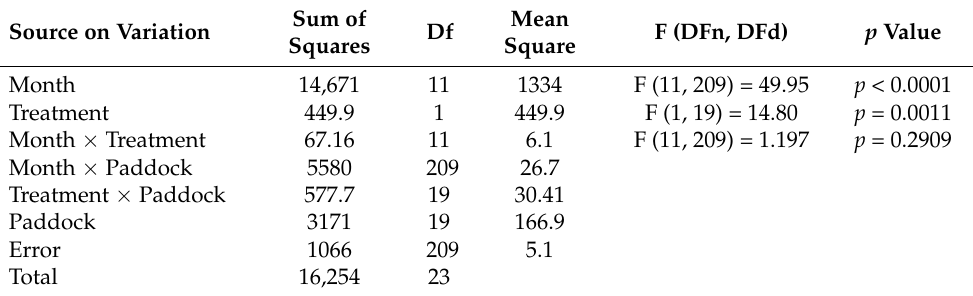
Table A10. Interannual Enhanced Vegetation Index (EVI) Variability two-way repeated measure ANOVA of natural grassland and Natural Grasslands overseed with Legumes with Phosphorus fertilization (NG-LP), during 9 years after intensification practice, between January and December ( n =